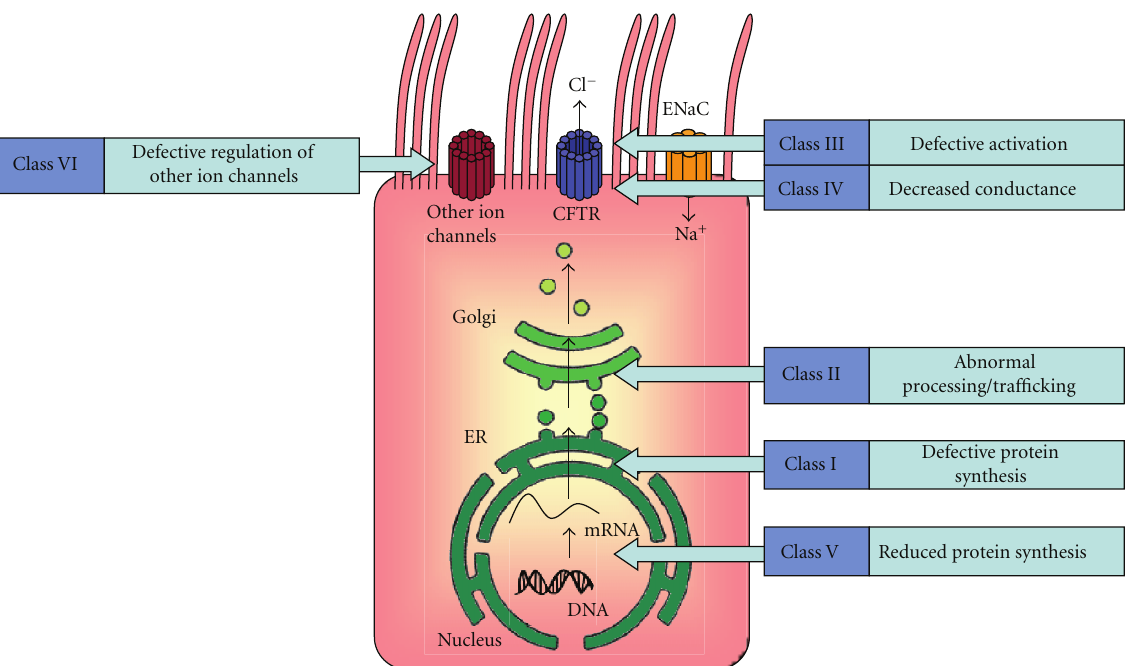
Figure 1: Classification of CFTR mutations. CFTR mutations are classified into six classes according to their e ff ect on CFTR function. Class I mutations inhibit biosynthesis, while Class II mutations a ff ect protein processing. Milder mutations such as Class III, IV, and VI impair CFTR channel function and Class V mutations a ff ect gene expression, adapted from Allen (1999)